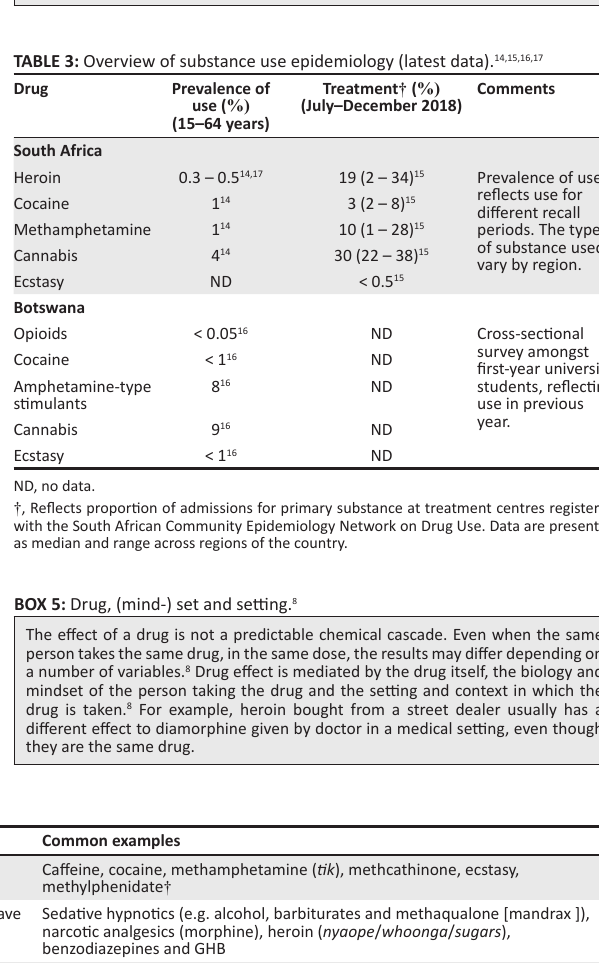
BOX 4: Image and performance-enhancing drugs.